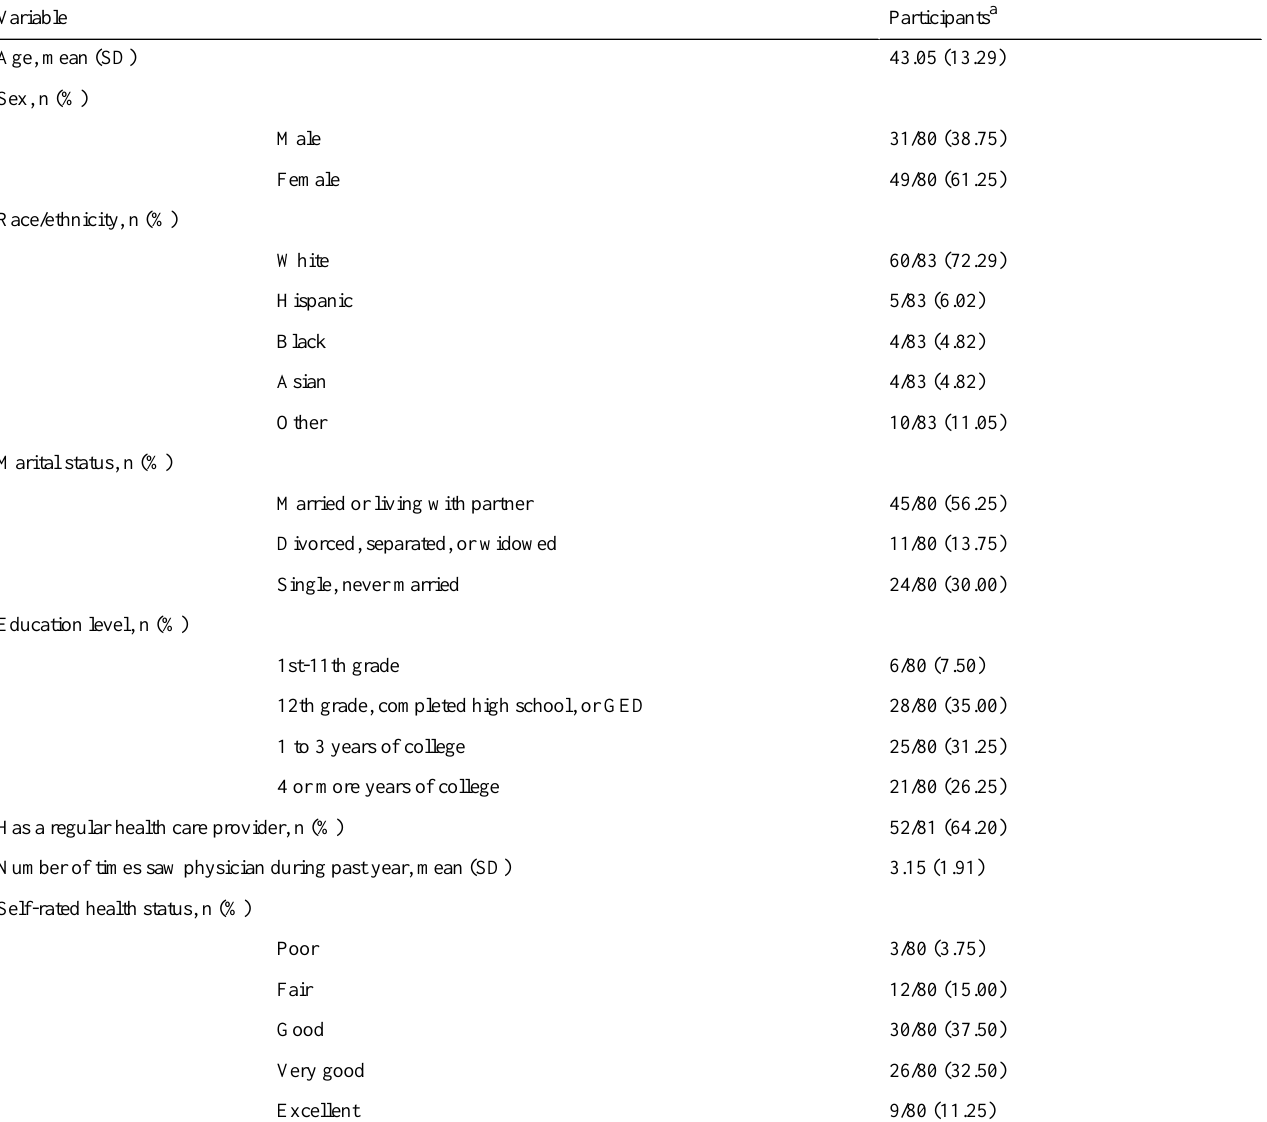
Table 1. Patient sample